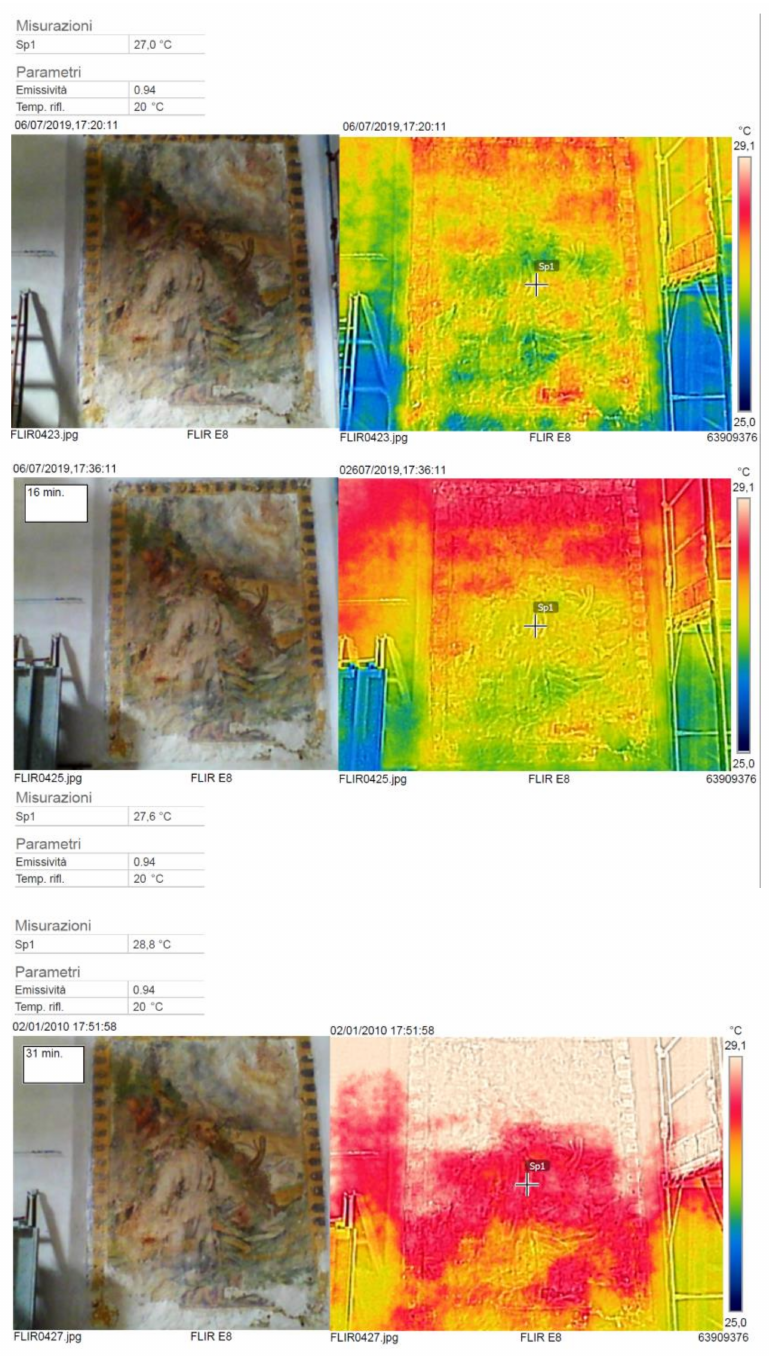
Figure 12. Investigation with thermal